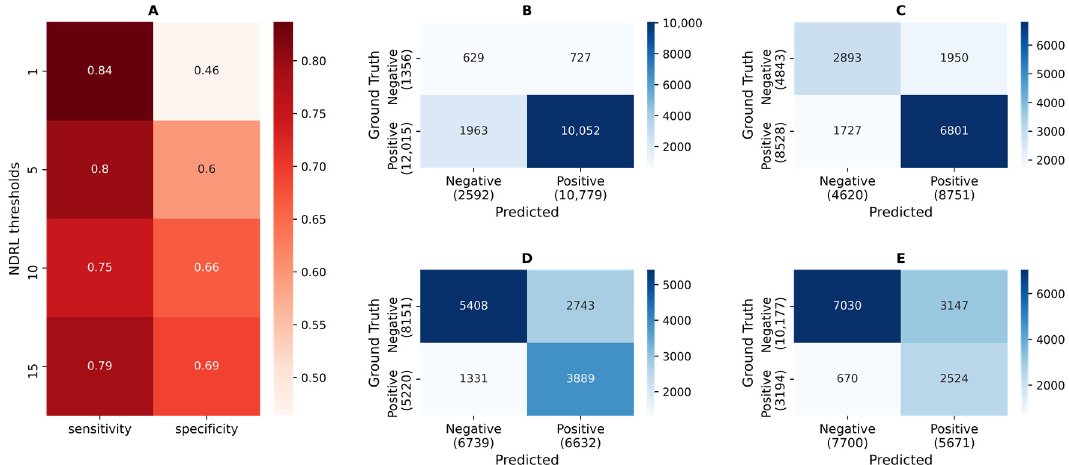
Figure 3. Sensitivity, specificity, and confusion matrix of the test set using the thresholds 1, 5, 10, and 15 for the NDRL. ( A ) shows sensitivity and specificity. ( B – E ) show, respectively, the confusion matrix using the NDRL thresholds of 1, 5, 10, and 15. The values are not normalized. Therefore the color cannot be compared between subplots. The ground truth, true categories, is placed on the left, and predicted values on the bottom. True positives are on the bottom right, and true negatives are on the top left.